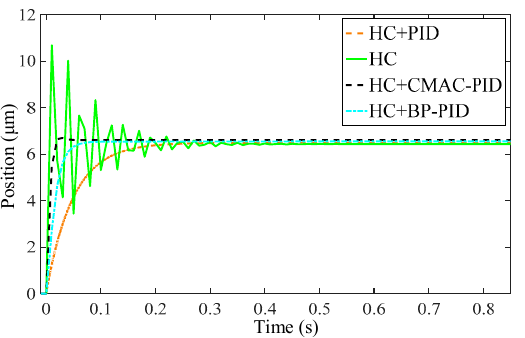
( d ) Figure 9. Schematic diagram of the inverse Preisach model compensation: ( a ) the hysteresis loop, ( b ) the inverse hysteresis loop, ( c ) the compensated output, and ( d ) the compensated output error. Based on the feedforward compensation above and the controller design in Section 3, the closed- loop response of the micro-positioner can be acquired by taking the unit step curve as the input signal, as depicted in Figure 10. Quantitatively tabulating the results of the designed controllers in Table 2, it is observed that the PID and BP-PID controllers can absolutely eliminate the overshoot, respectively shortening the settling time by 0.16 s and 0.38 s, and promoting the settling value by 0.059 μ m and 0.113 μ m compared with the desired value of 6.613. Although the CMAC-PID controller gives a moderate response speed with about 1.39% overshoot, the response can reach stability with the quickest transient response and obtain the final value closest to the ideal. Therefore, CMAC-PID controller is chosen to the optimal, thanks to the best approving control effect comparatively. Table 2. Controller performance for compensation simulation.